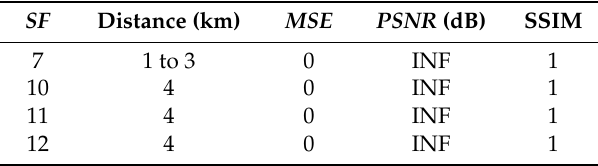
Table 7. LoRa physical SF setting which has identical image quality